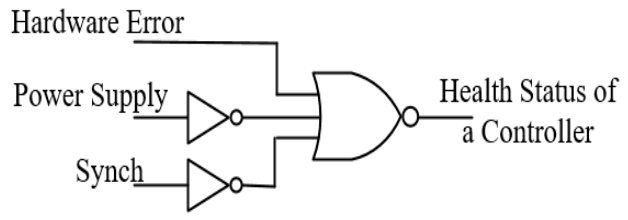
Figure 7. A logic diagram of the health status check controller.